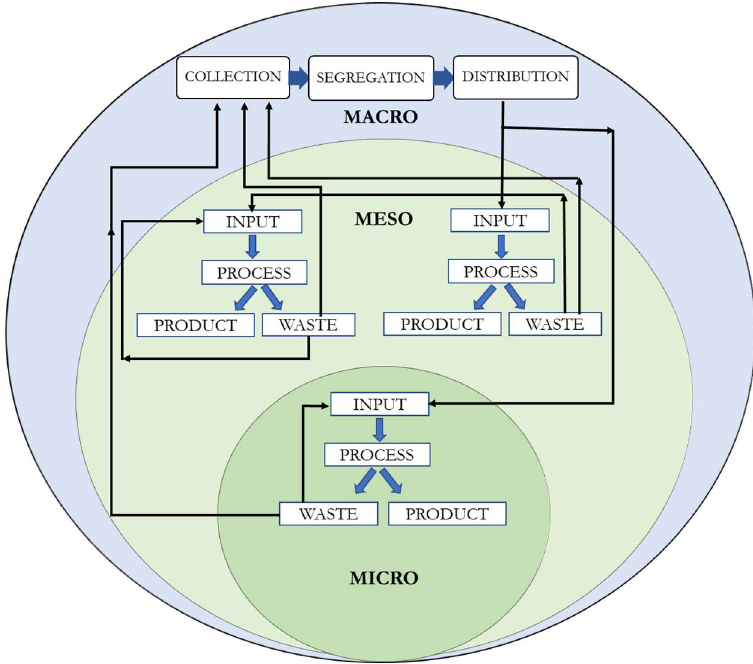
Levels of circular